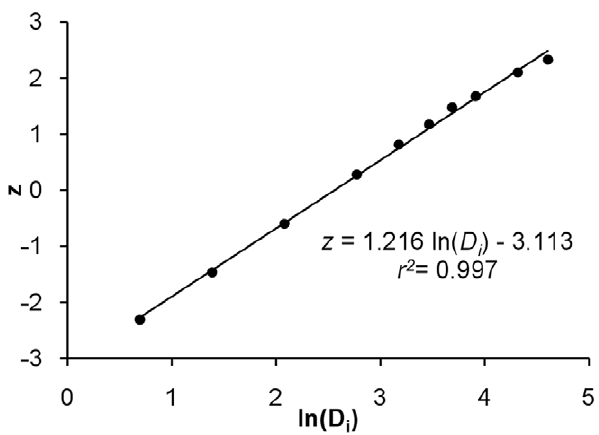
Figure 1. Log-probability plot of droplet size distribution from a cough, adapted from Duguid [ 20 ] . D i is the initial droplet size in m m, and z is the corresponding quantile of a normal distribution with the same cumulative